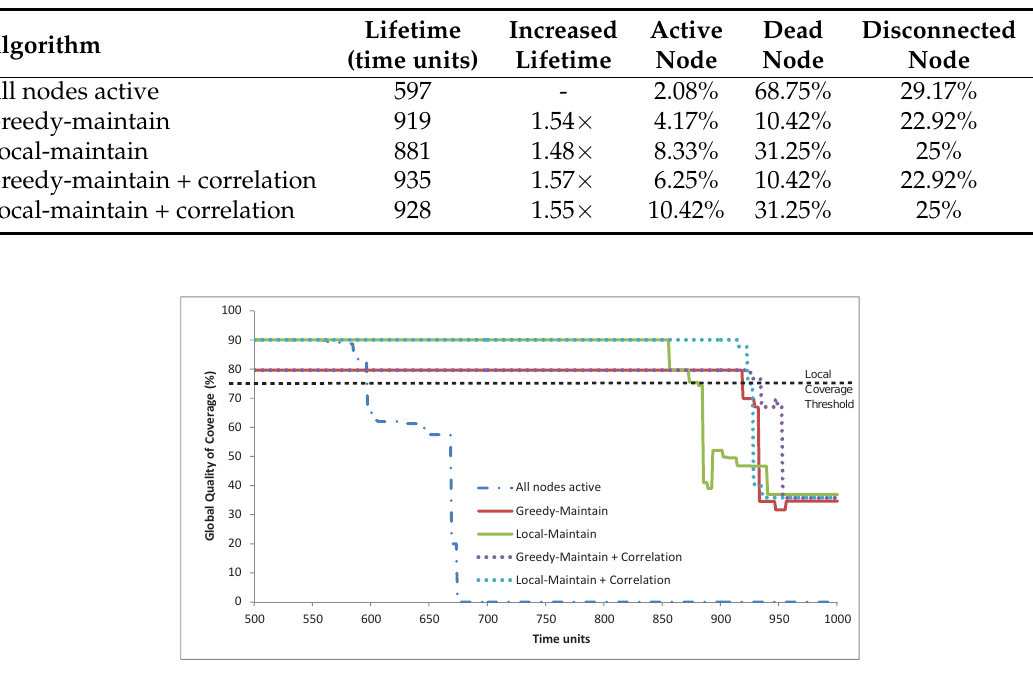
Table 8. CIT-1’s simulation results.